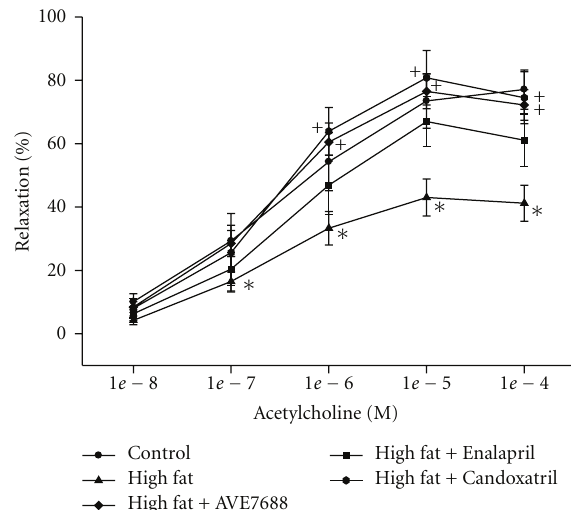
Figure 5: E ff ect of a high-fat diet and treatment with AVE7688 on calcitonin gene-related peptide-(CGRP)-mediated vascular relax- ation of epineurial arterioles. Rats were fed a standard or high- fat diet with or without AVE7688, Enalapril, or Candoxatril for 24 weeks. Arterioles were derived from rats as described in Figure 4. Incremental doses of CGRP were added to the bathing solution while recording steady state vessel diameter. Data are presented as the mean of % relaxation ± SEM. The number of rats in each group was the same as shown in Table 1. ∗ P < . 05, compared to rats fed the standard diet (control), + P < . 05, compared to rats fed the high- fat